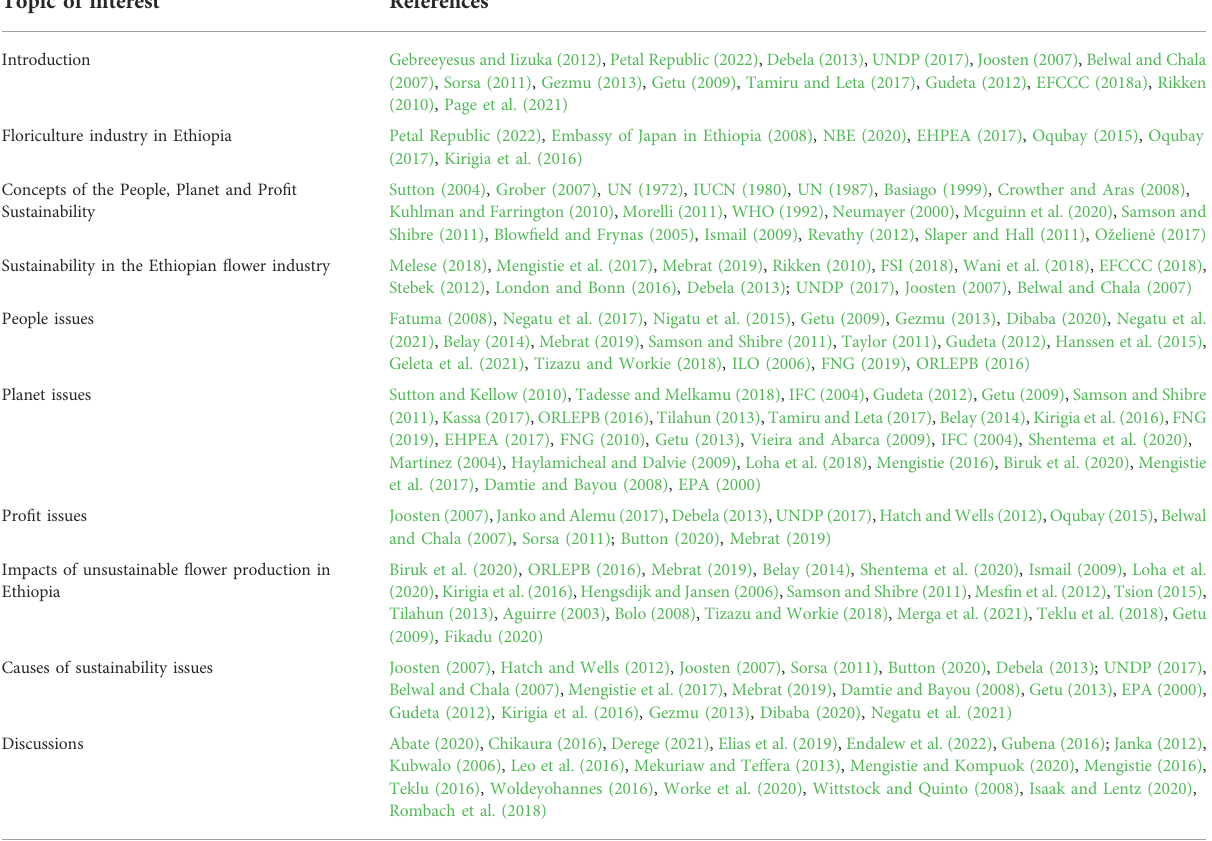
TABLE 1 Summary of the subtopics of the manuscript with citations used.